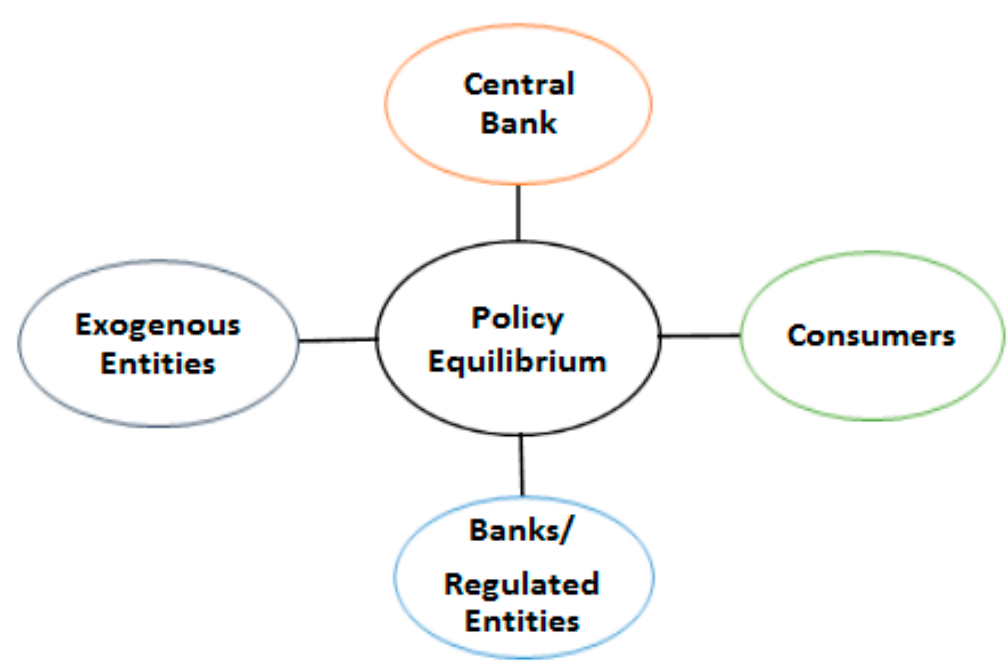
Figure A3. Regulatory policy change management dimensions.